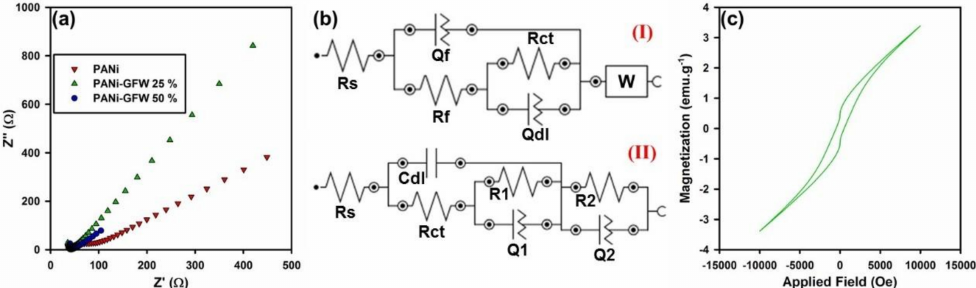
Figure 8. ( a ) Nyquist plots of PANi and reinforced PANi with diverse filler loadings of GO-ITN, ( b ) used circuits for measuring the electrical conductivity of (I) PANi and (II) reinforced PANi with 50 wt % GO-ITN, and ( c ) the outcome of VSM analysis for reinforced PANi with 50 wt % GO-ITN hybrid flakes.